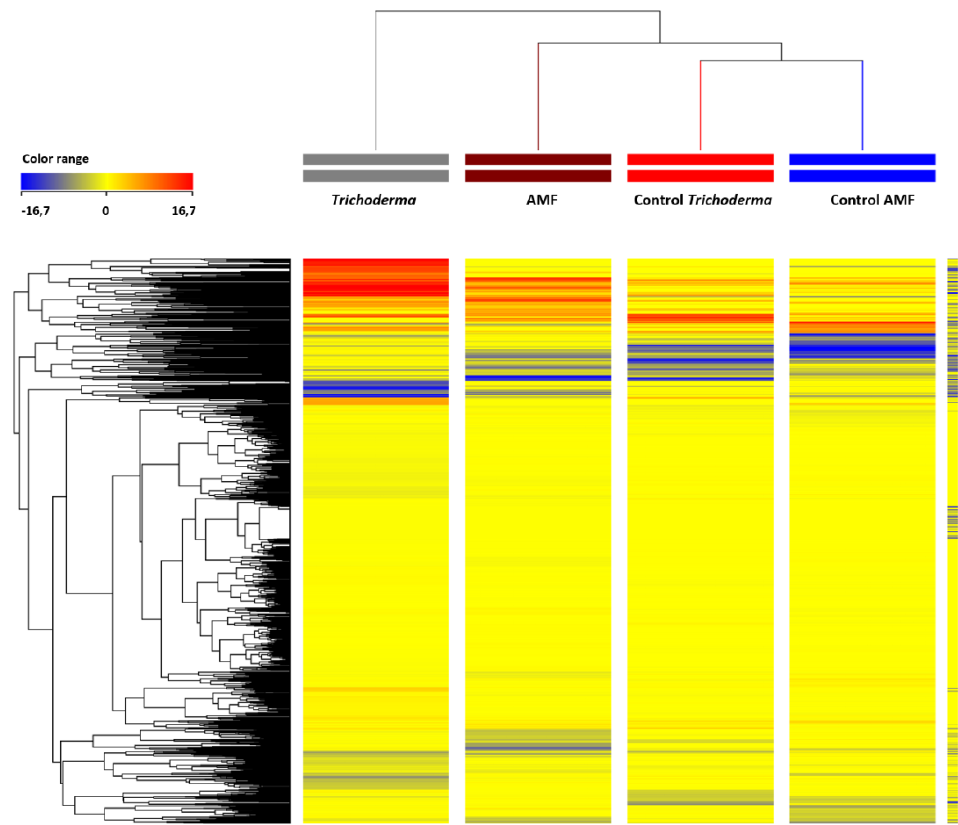
Figure 1. Unsupervised hierarchical cluster analysis (Euclidean distance; linkage rule: Ward) of to- mato leaf chemical profiles after biostimulant treatments. Metabolites were obtained by UHPLC- ESI/QTOF-MS untargeted analysis, and their intensities were used to create the fold-change heat map provided here. The color range represents the fold-change values used to build the heat-map (the color range is provided in Figure 1).